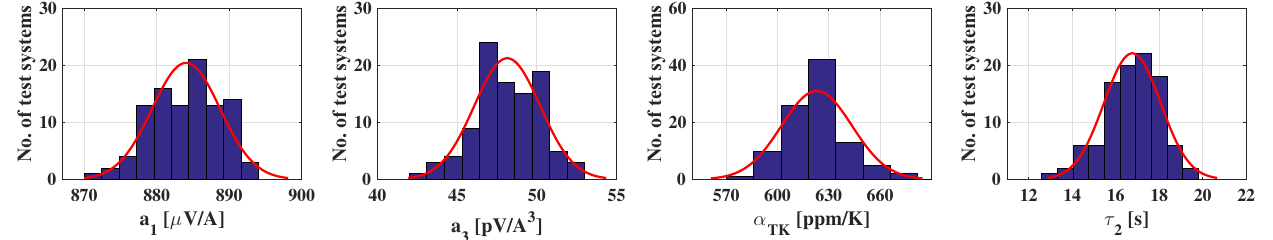
Figure 12. Statistical distribution of selected calibration parameters for 100 distinct test systems.